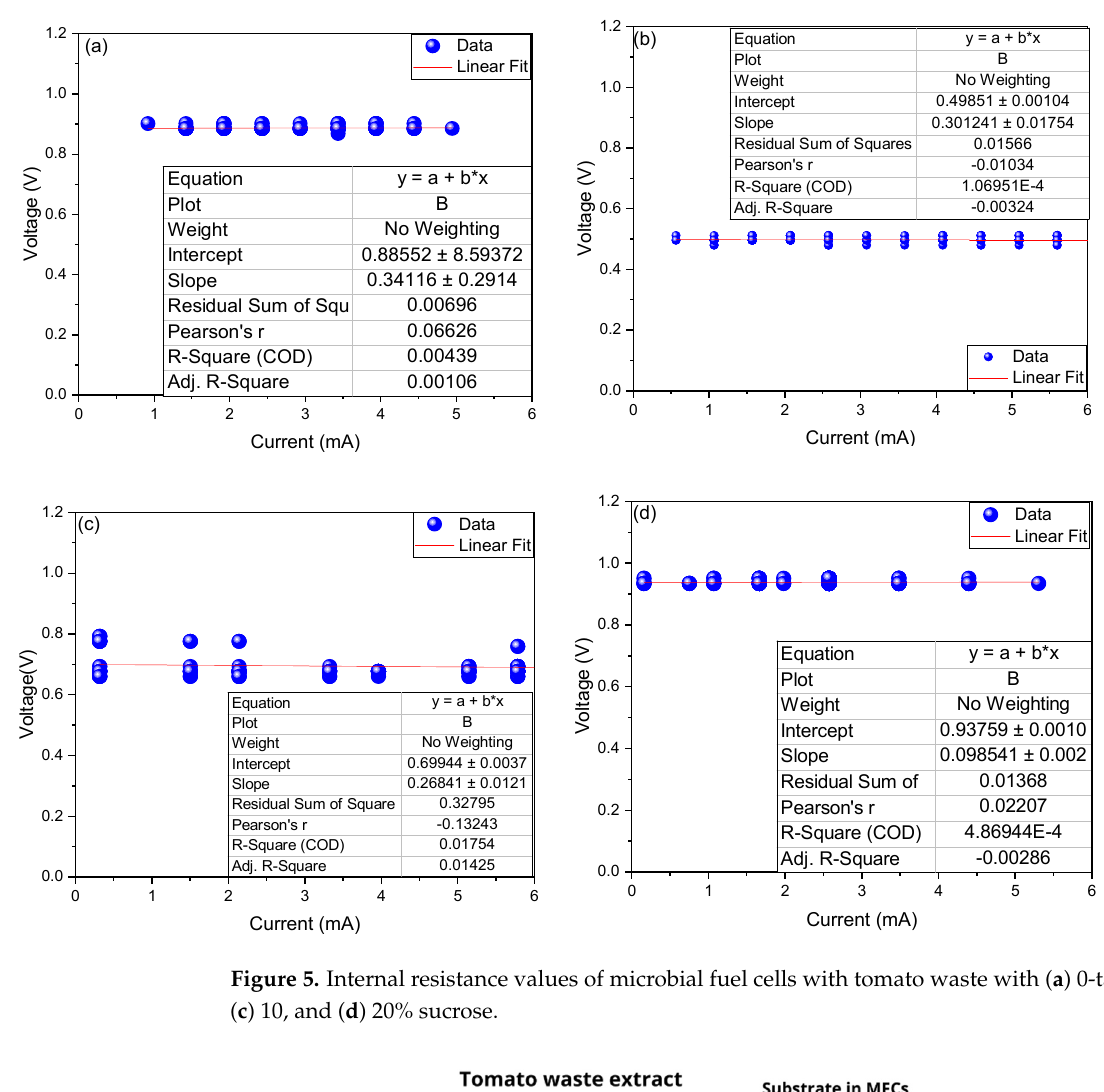
Figure 5. Internal resistance values of microbial fuel cells with tomato waste with ( a ) 0-target, ( b ) 5, ( c ) 10, and ( d ) 20% sucrose.